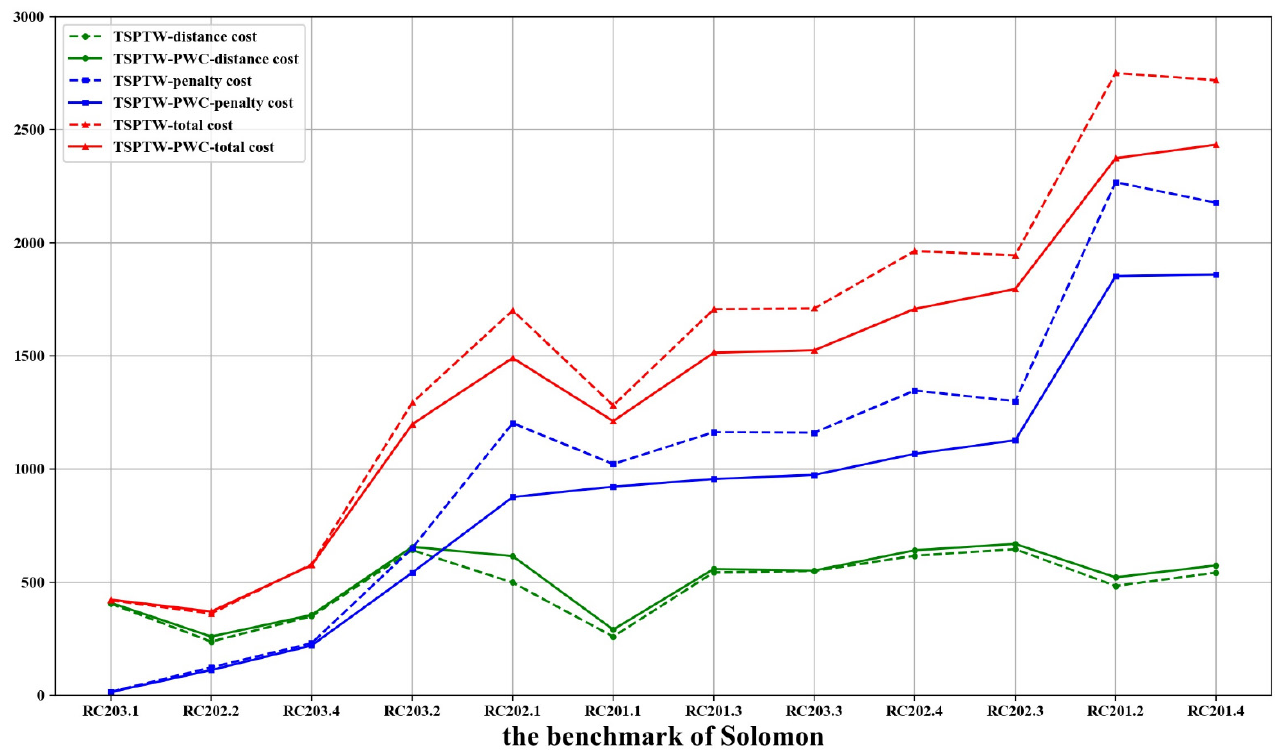
Figure 3. Comparison of TSPTW and TSPTW-PWC.